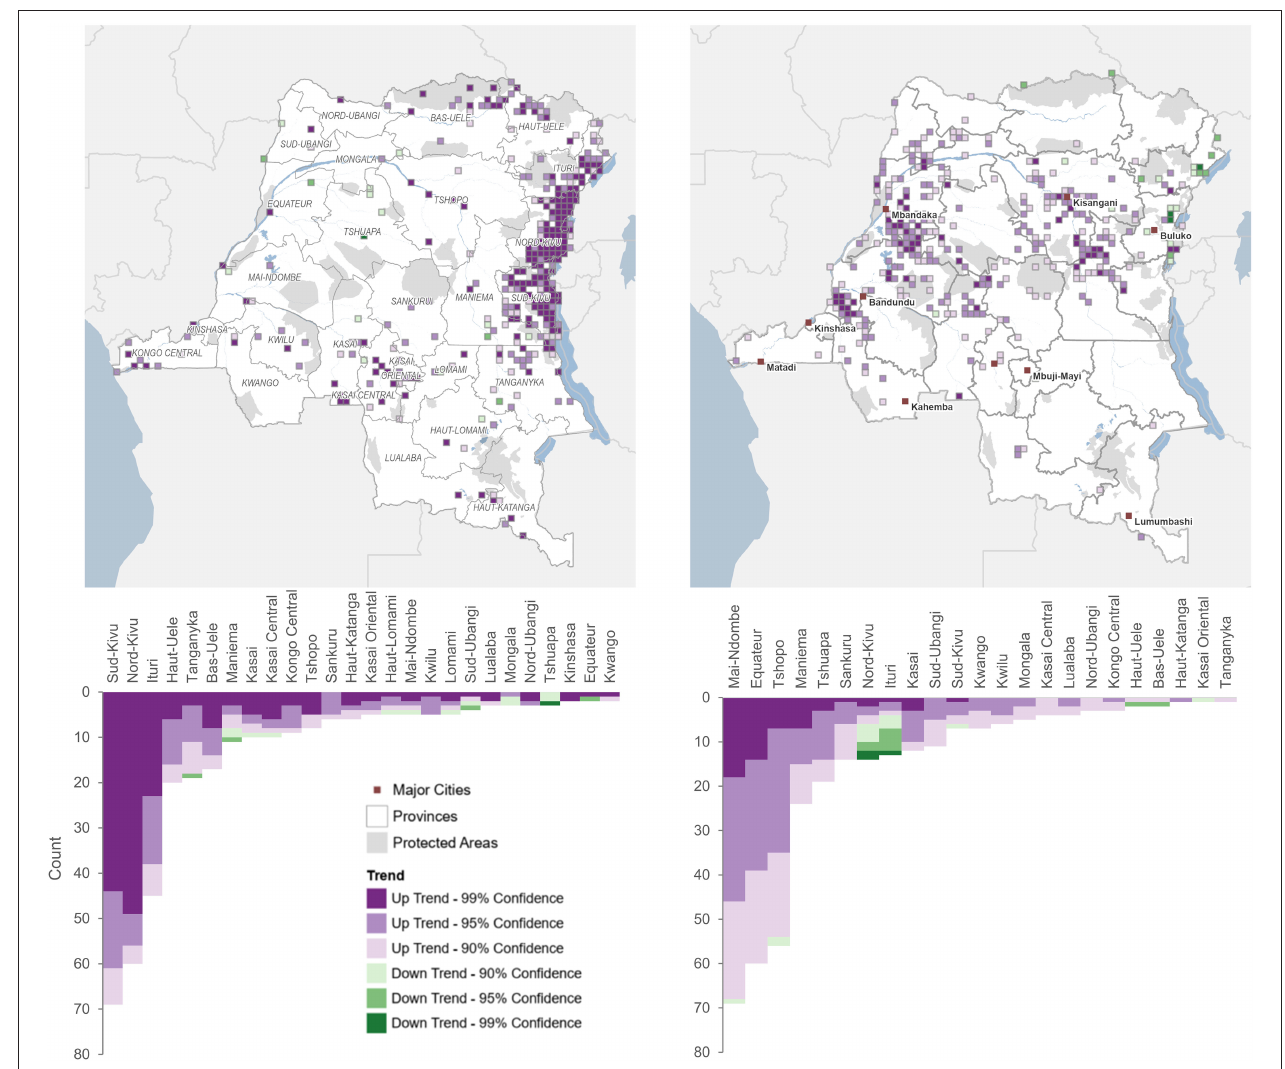
FIGURE 6 | Trends in conflicts (left) and fires (right) assessed by Mann-Kendall trend